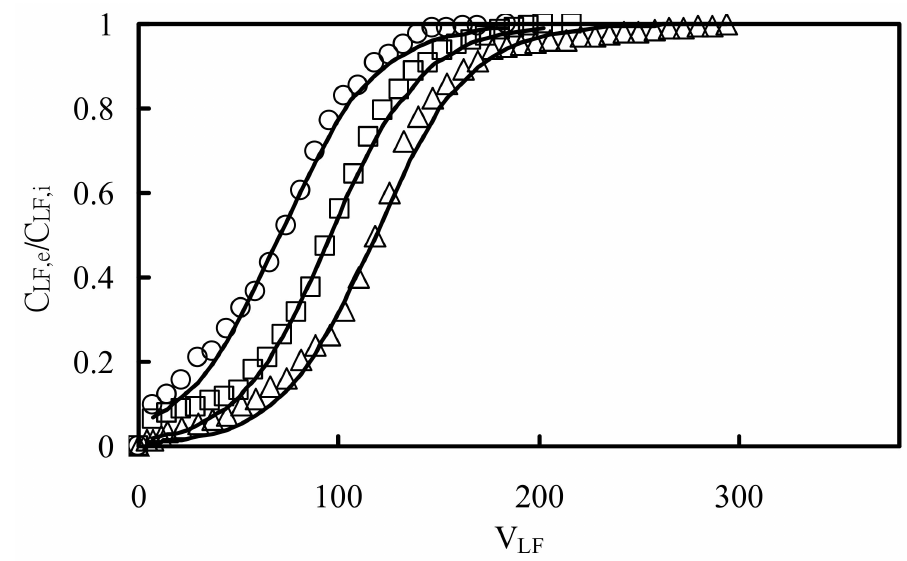
Figure 4. Breakthrough curves for the solution containing M-PVAC-IDA using HGM separator (HGF-10 1) at various Q LF with C LF , i = 2.06 g L − 1 . , (cid:3) , (cid:52) : Q LF = 0.833, 0.545, 0.417 L min − 1 (cid:35) ( v 0 = 1.731, 1.132, 0.866 m min − 1 ). —: Prediction. C LF , e , C LF , i , V LF , Q LF : As specified in Figure 3.